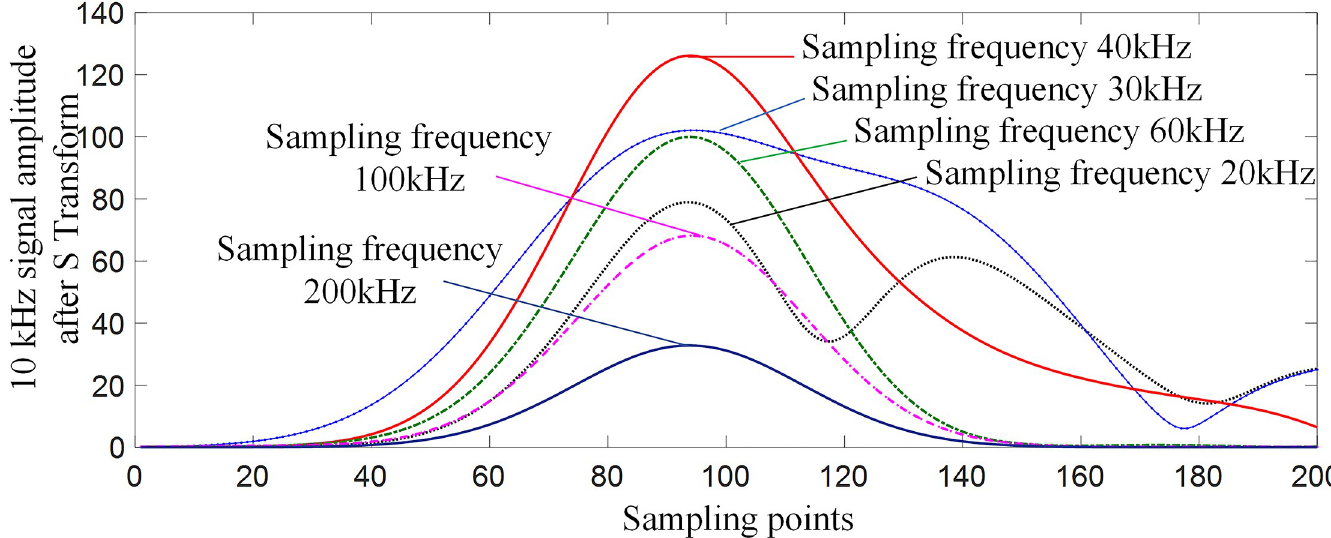
Fig 11. Amplitude comparison of 10 kHz frequency component signals after S-transform at different sampling frequencies. https://doi.org/10.1371/journal.pone.0230717.g011 pole faults (IPG, ING) on the inverter side, the transitional resistance is set in the same way as it is in the zone, so there are a total of 4 × 8 = 32 external data samples that are insusceptible to noise interference. The sampling of external noise interference data samples are consistent with that of external non-noise interference data samples, which are 4 × 8 = 32 as well. There- fore, the total number of training samples in this paper is 3 × 11 × 8+4 × 32+4 × 32 = 328.